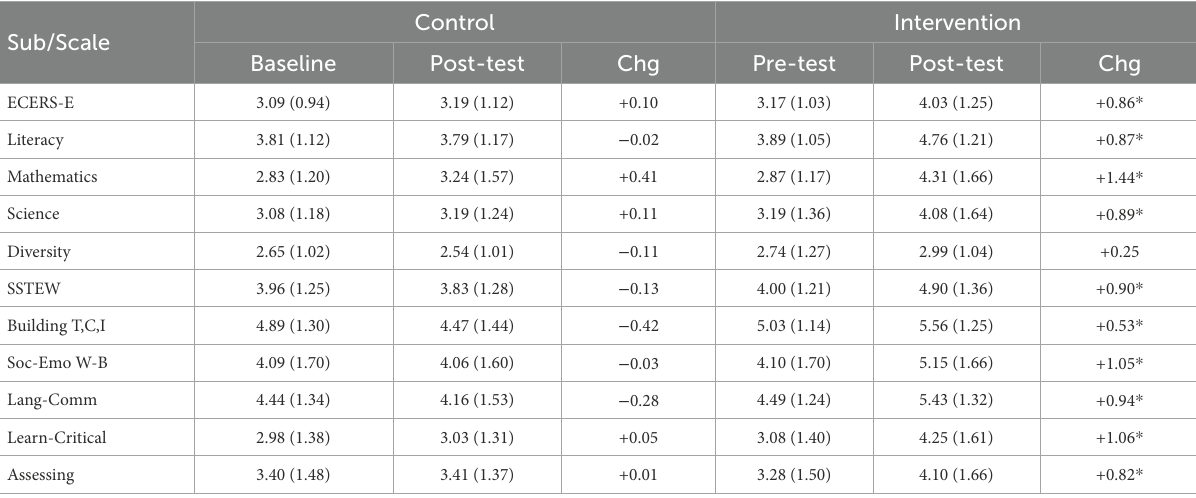
TABLE 3 Baseline and follow-up ratings by